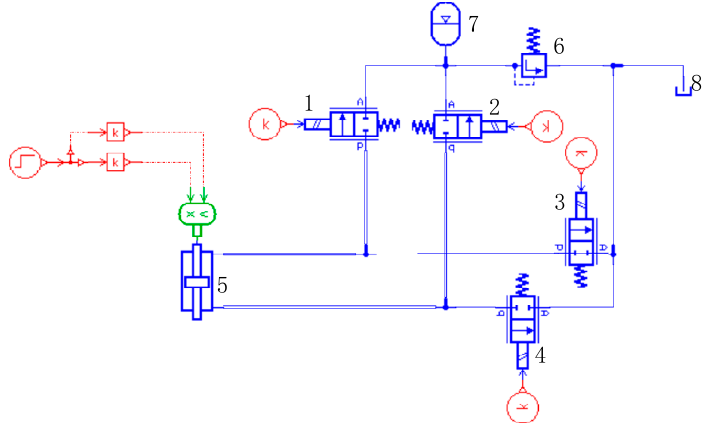
Figure 8. AMESIM model of hydraulic loading system.